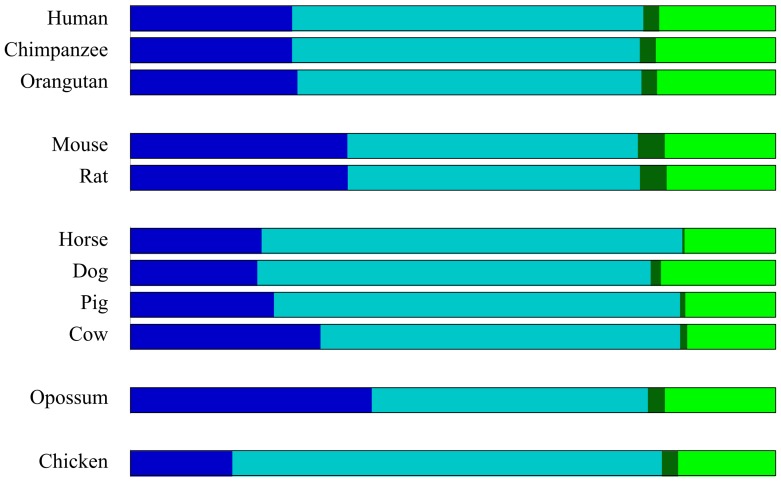
Genomic coverage of four compositional domain types.Homogeneous domains are in blue shades; nonhomogeneous domains are in green shades. Domains longer than 300 kb are in dark shades; domains shorter than 300 kb are in light shades. Compositionally homogeneous domains longer than 300 kb (i.e., isochoric domains) are in dark blue.